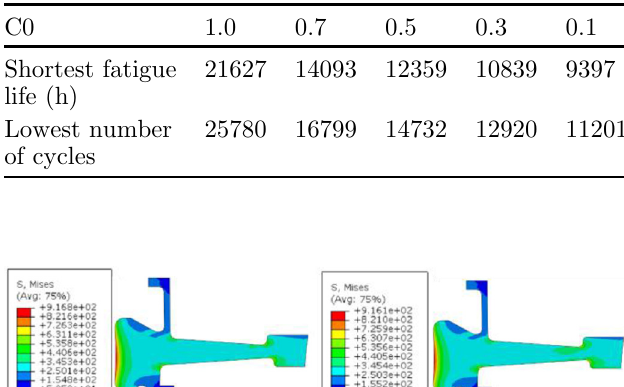
Table 14. Logarithmic fatigue lives of turbine disc for different C0 values.